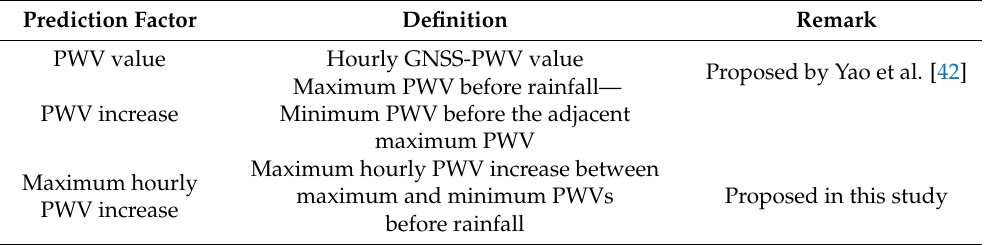
Table 4. Definition of the three prediction